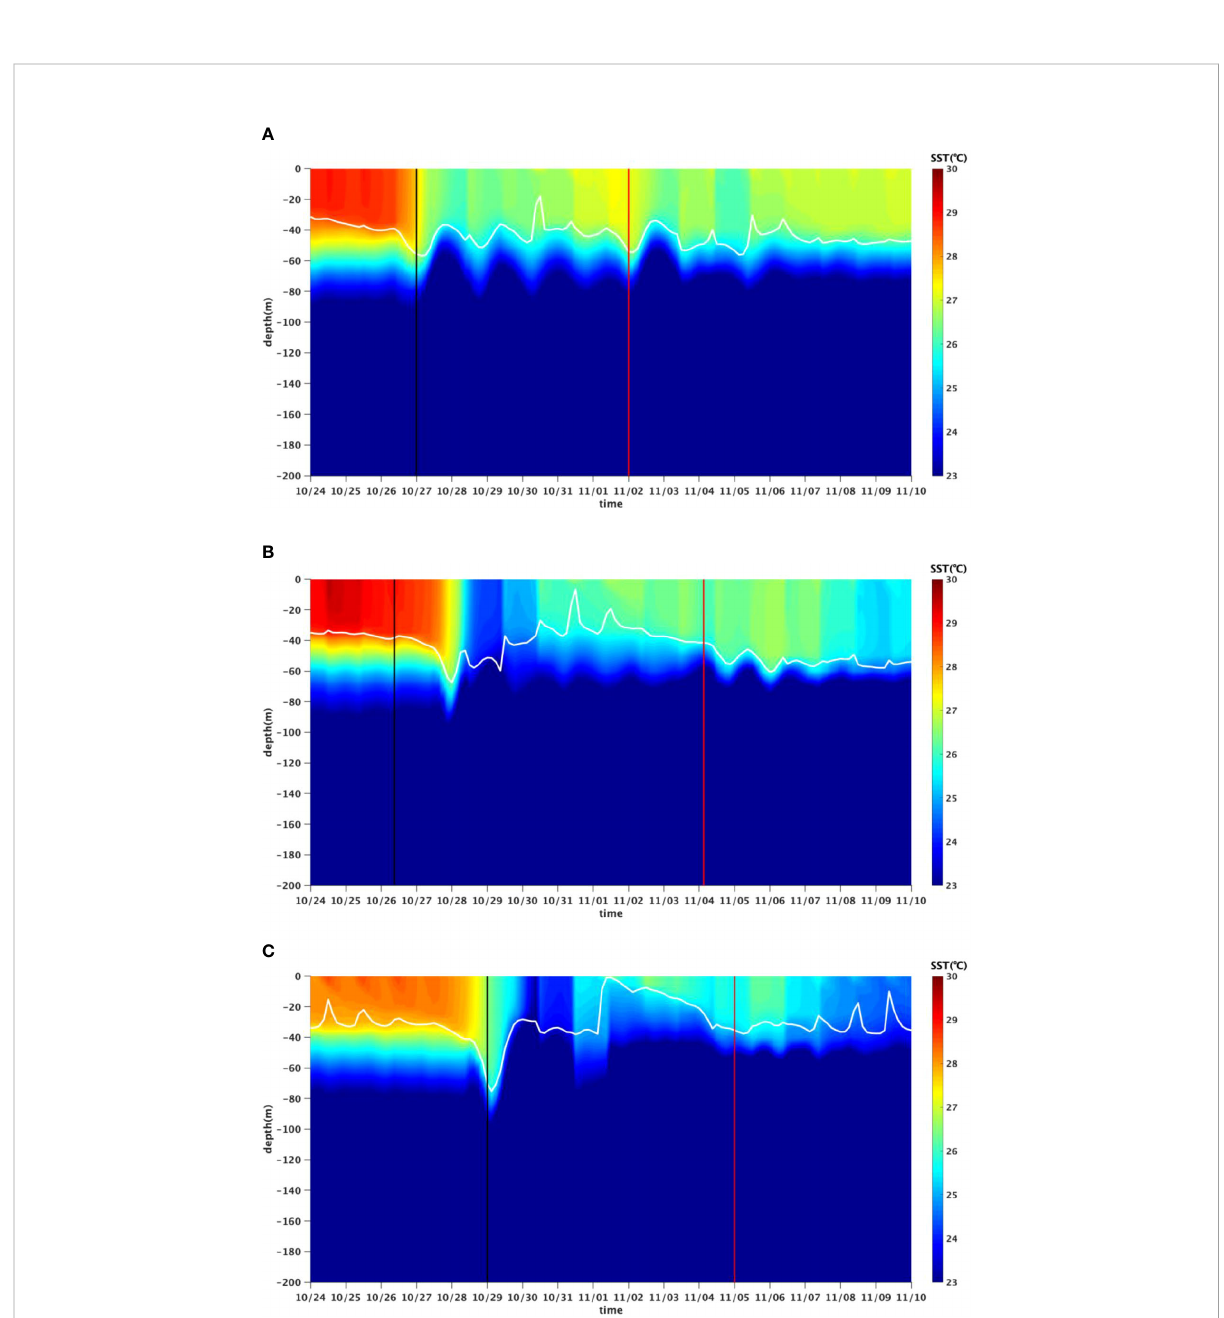
FIGURE 10 Vertical pro fi les of temperature in the central range of each eddy over time. (A) : Vertical pro fi les of temperature in the central range of e1 over time. (B) : Vertical pro fi les of temperature in the central range of e2 over time. (C) : Vertical pro fi les of temperature in the central range of e3 over time. The solid white lines indicate the depth of each eddy centre mixed-layer. The black and red solid lines denote the times when Kyarr and Maha passed by each eddy,